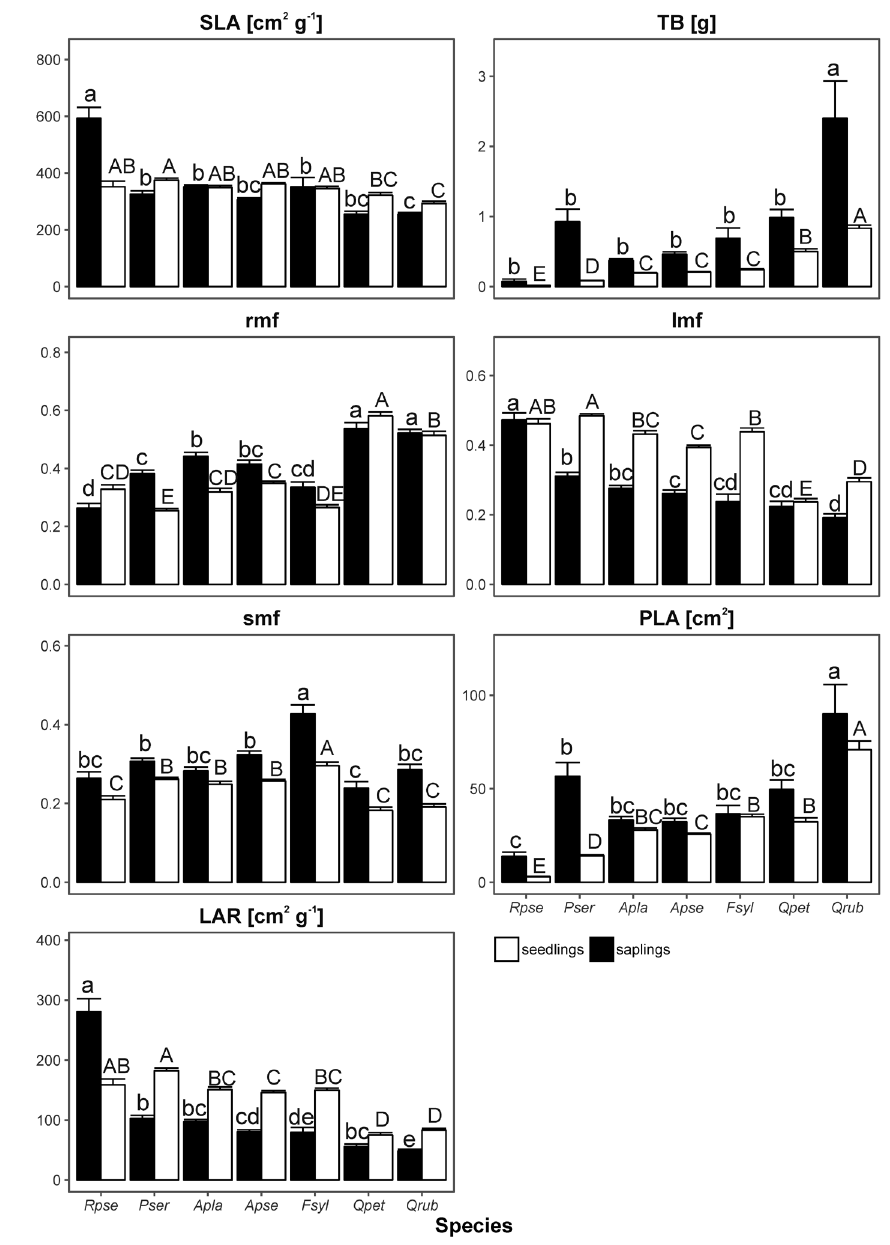
Figure 2. Mean (+SE) values of species traits of natural regeneration: SLA – specific leaf area (cm 2 g -1 ), TB – total biomass [g], rmf – root mass fraction, lmf – leaf mass fraction, smf – stem mass fraction, PLA – projected leaf area [cm 2 ], LAR – leaf area ratio [cm 2 g -1 ]. Differences were assessed using one-way mixed effects ANOVA and Tukey post hoc tests – species marked by the same letter (lower-case letters for saplings and upper-case letters for seedlings) did not differ significantly statistically (p<0.05). ANOVA details are provided in Suppl. material 1: Table S1. Species are ordered according to successional